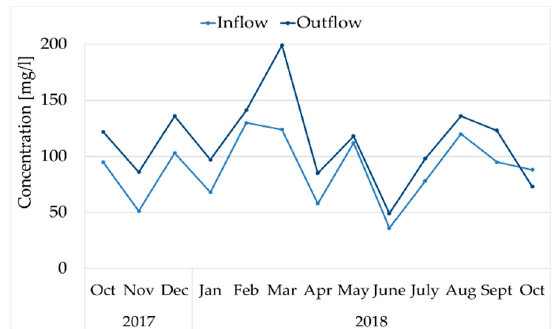
Figure 10. Chloride concentration in inflow and outflow water at Site A.